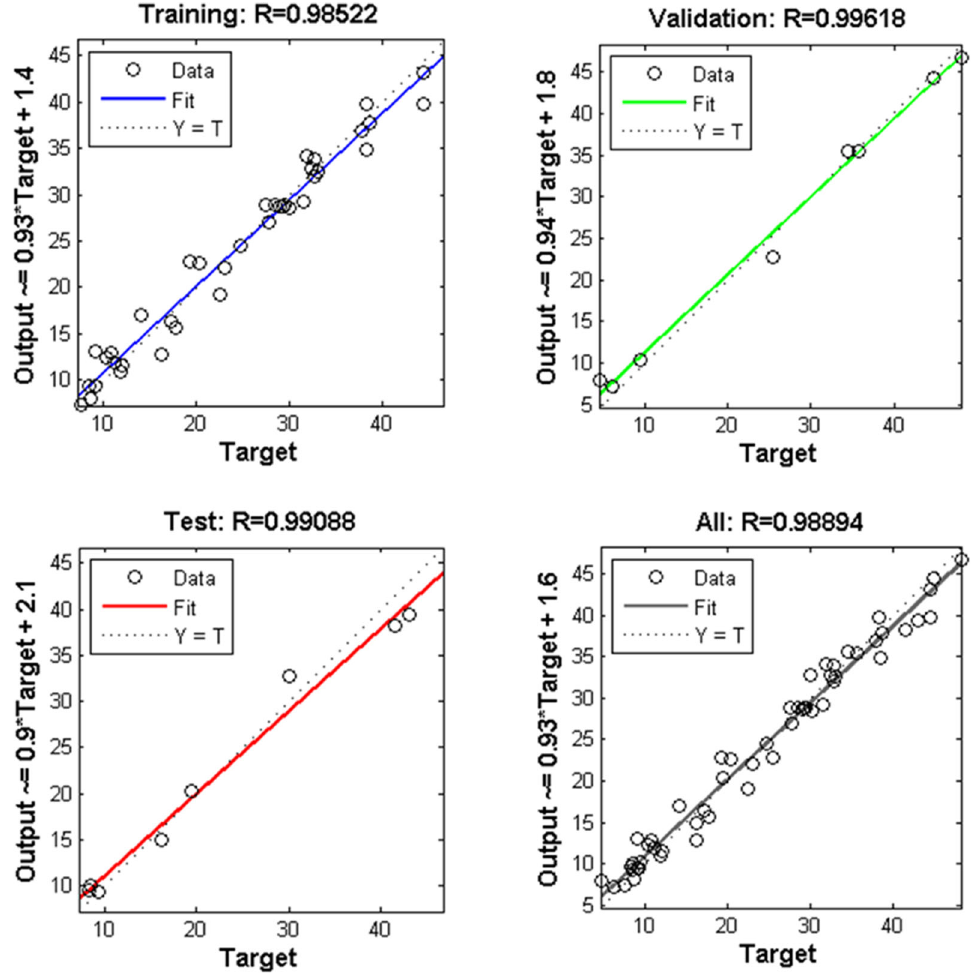
Fig. 3 Trained network for C þ